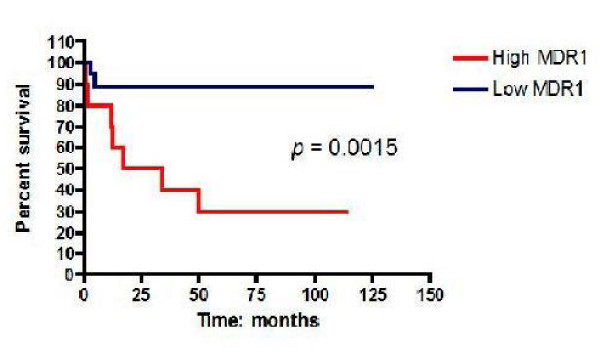
Disease specific survival rate according to MDR-1 expression. The high expression patients showed a significantly worse survival than low expression patients. Kaplan-Meier analysis displays a significant result (p < 0.05).